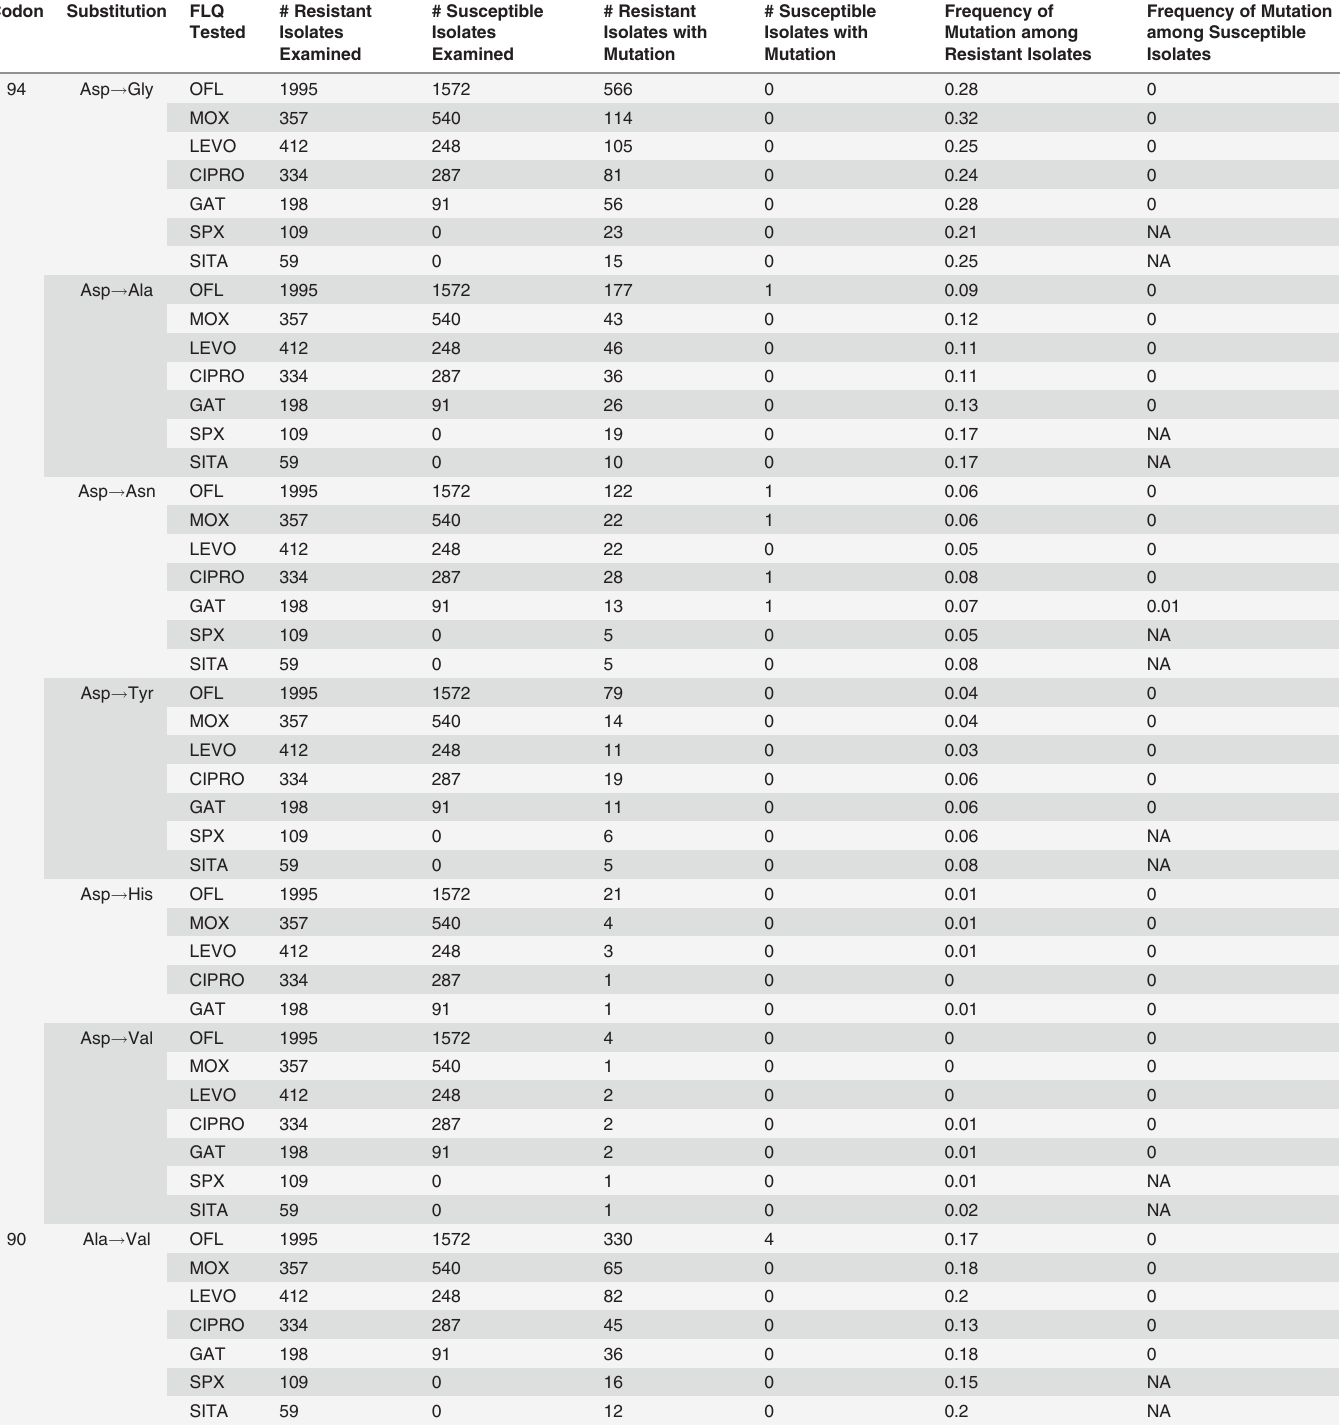
Table 3. Cumulative Frequencies of the Most Frequently Occurring Mutations within gyrA Gene among Mycobacterium tuberculosis Isolates Resistant to Fluoroquinolones. Mutations are listed in order of descending frequency. Codon Substitution FLQ